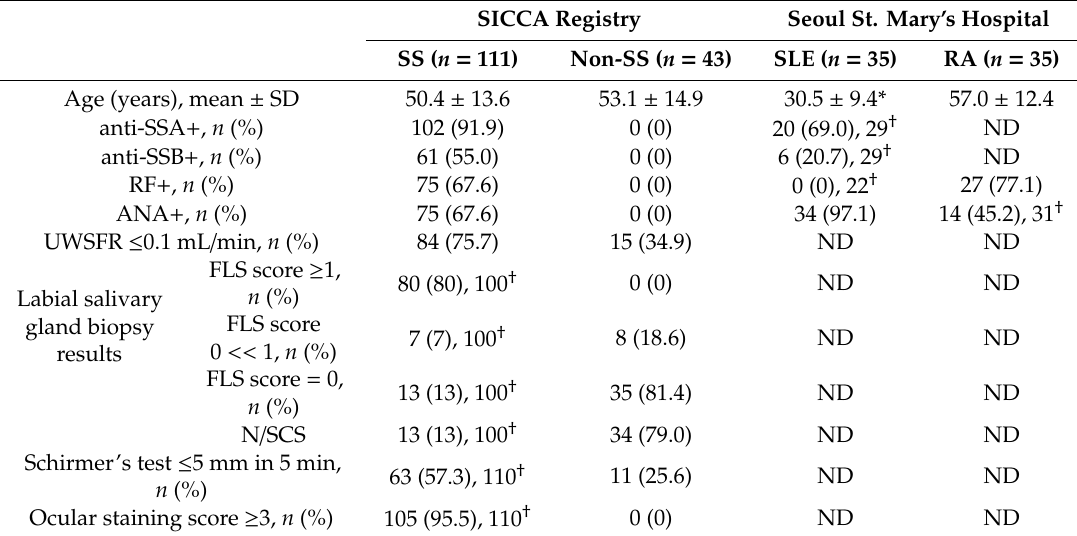
Table 1. Demographic and laboratory characteristics of the